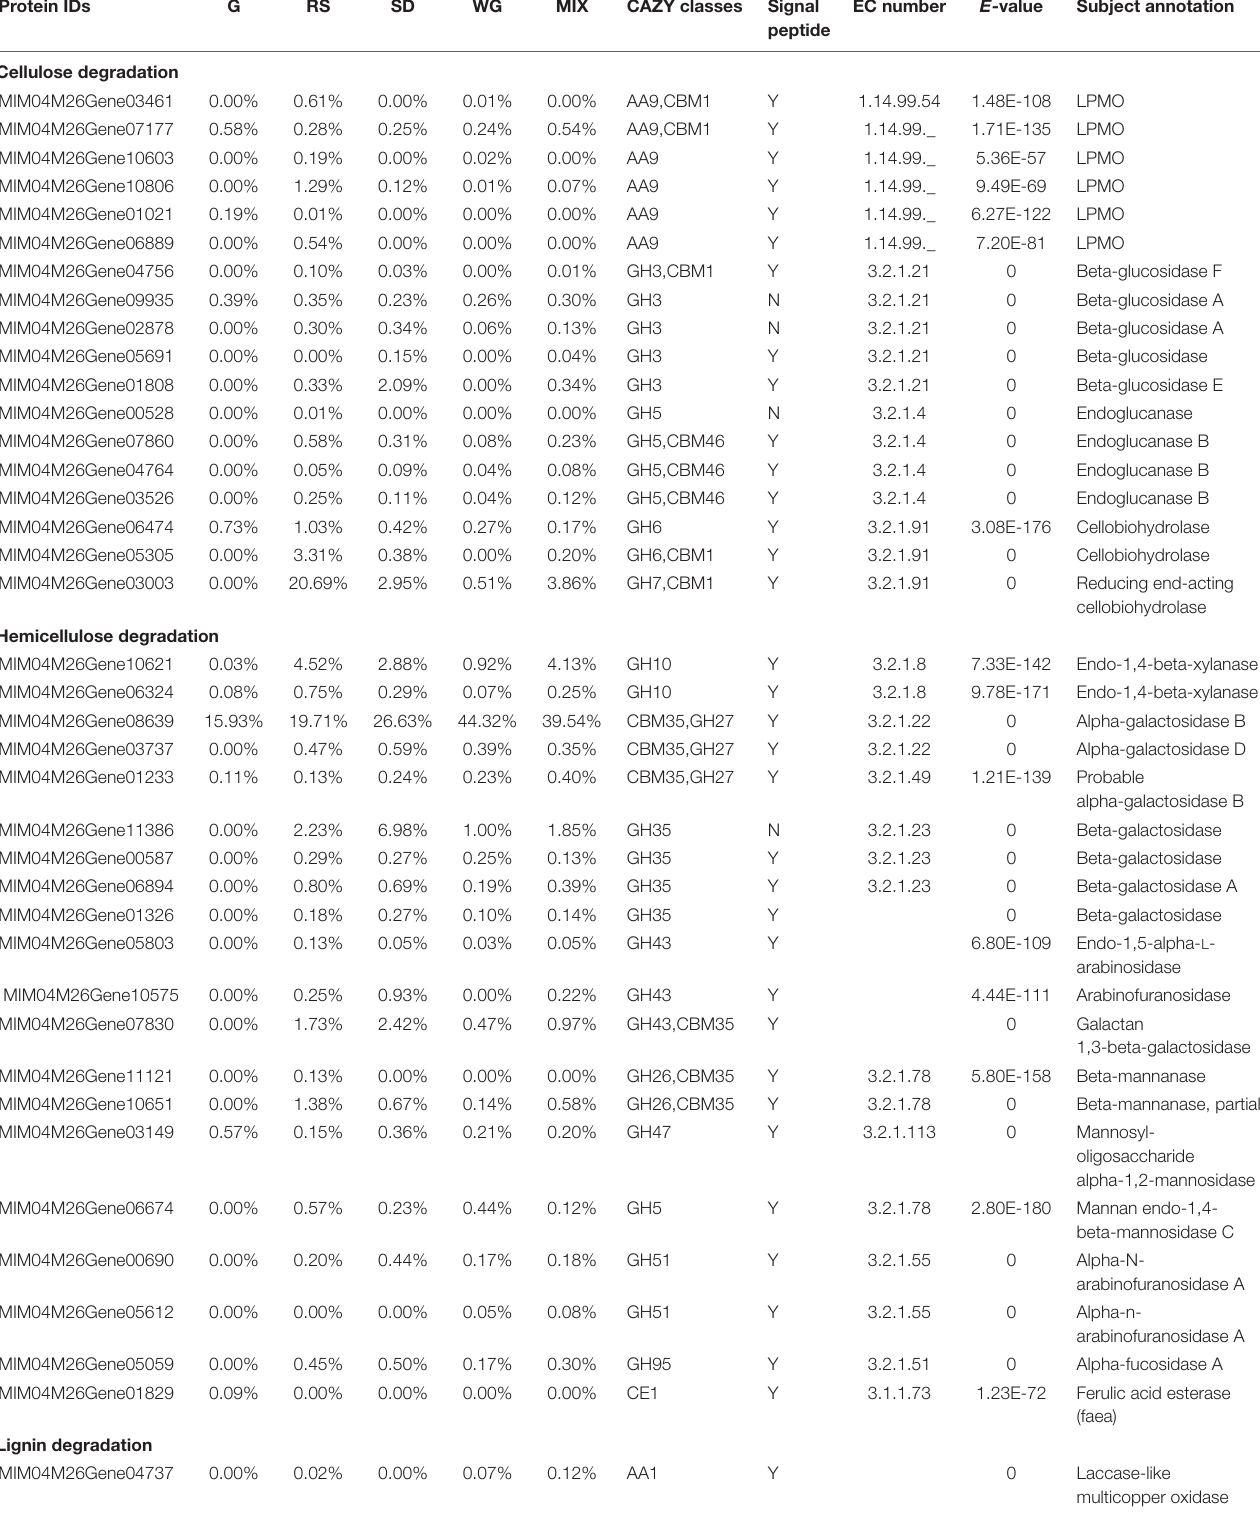
TABLE 2 | Secretome of Morchella importuna in five different substrates. Protein